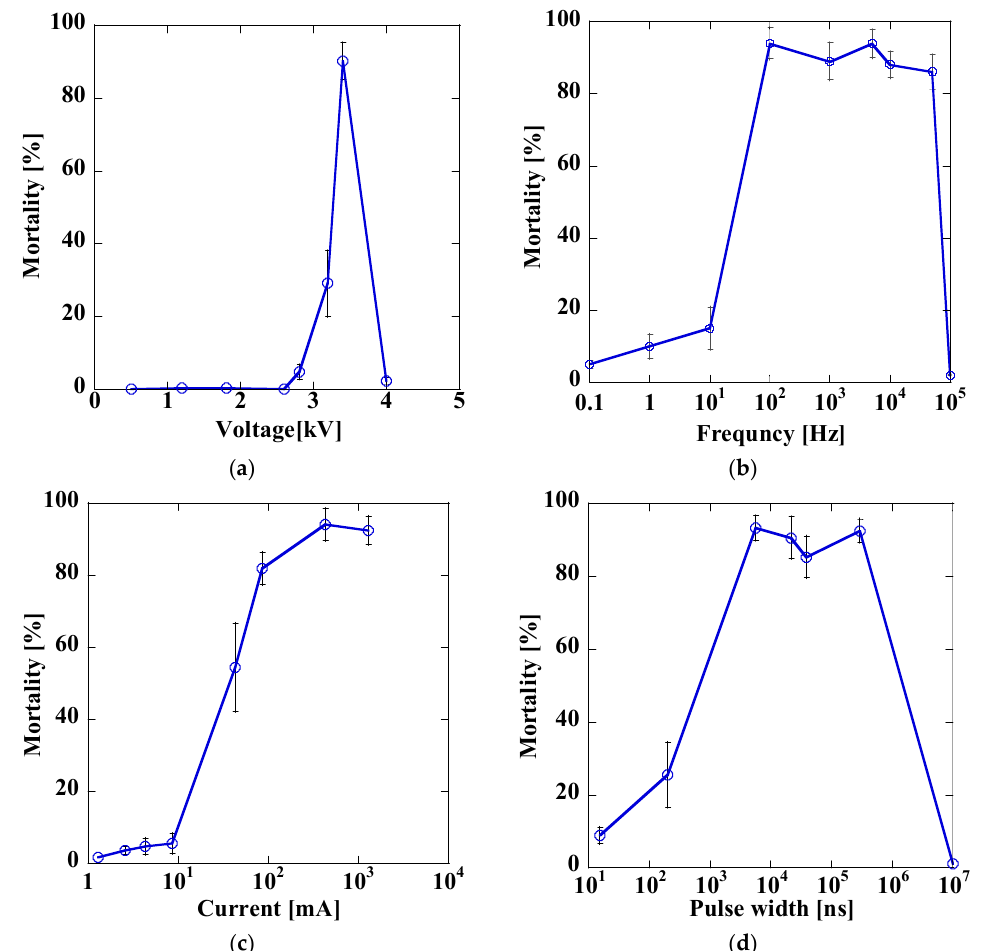
Figure 5. Variation in mortality with electrical parameters. ( a ) Variation in mortality with discharge voltage. Killing of D. gallinae was found to be highly unlikely. As the voltage was increased, the mortality increased; however, this rate decreased rapidly at higher voltage levels. At an electrode spacing of 0.5 mm, the voltage was 3.5 kV and the maximum mortality was 90.4%. The electrodes were made of glass epoxy, the electrode spacing was 0.5 mm, and the frequency was 100 Hz. The error bars in the data indicate the standard deviation. ( b ) Variation in mortality with frequency. The mortality was found to be significantly low at frequencies below 10 Hz, while frequencies above 100 Hz resulted in a high mortality of over 90%. However, at frequencies above 100 kHz, discharges were observed to occur at consistent locations on the electrodes, resulting in a significant reduction in mortality. The electrodes were made of glass epoxy and operated at a voltage of 3.5 kV with a spacing of 0.5 mm. Error bars in the data indicate the standard deviation. ( c ) Variation in mortality with current. The mortality showed a marked increase when the current exceeded 10 mA, culminating in a maximum mortality of 94.2% at a current of 427 mA. Error bars in the data indicate the standard deviation. The electrodes were made of glass epoxy and operated at a voltage of 3.5 kV, with a distance of 0.5 mm between electrodes, and a frequency of 100 Hz. ( d ) Variation in mortality with pulse width. When the pulse width is in the order of nanoseconds, the mortality is low, with values of less than 40%. However, when the pulse width is in the order of microseconds, the mortality exceeds 80%. In addition, increasing the pulse width to the order of milliseconds did not result in a high mortality. The electrodes were made of glass epoxy and operated at a voltage of 3.5 kV, with a distance of 0.5 mm between electrodes, and at a frequency of 100 Hz. Error bars in the data indicate the standard deviation.